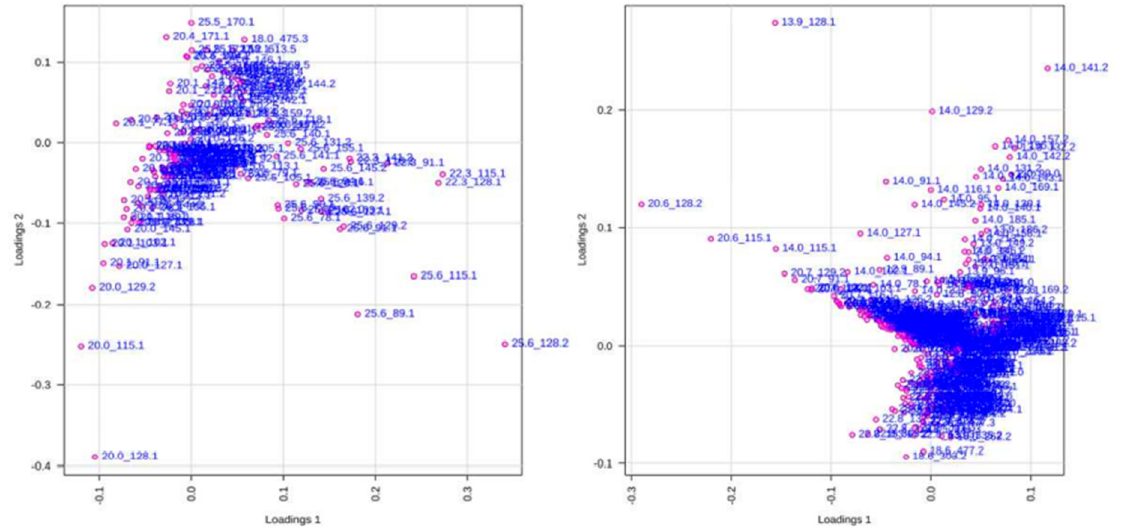
Figure 8. Score plots of 12 samples of organic and aqueous extracts of all manipulation, obtained from 168 ( left ) and 412 ( right ) variables, respectively. Each dot represents one variable (retention time m/z).